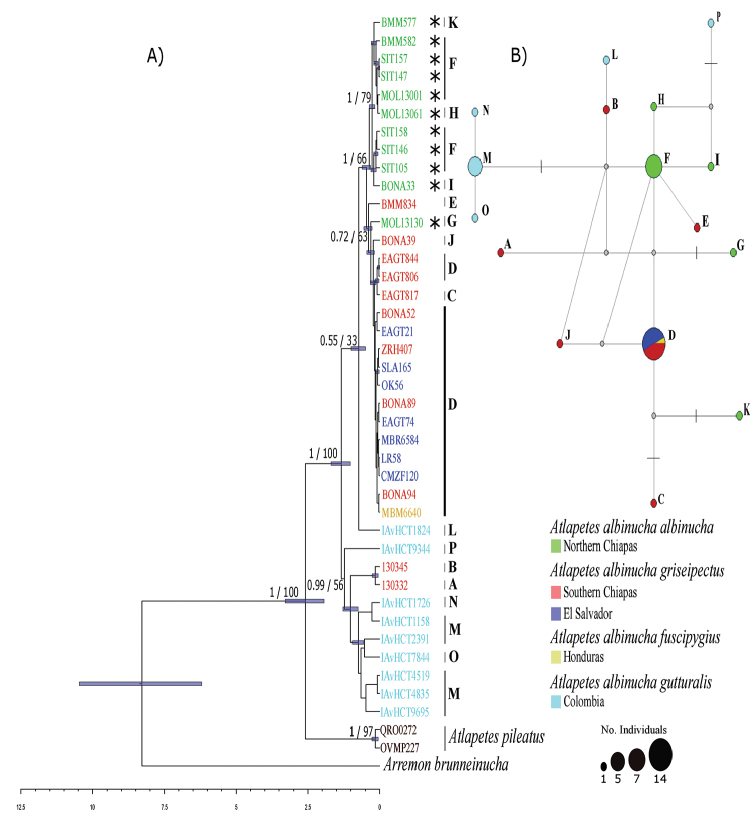
A Dated Bayesian maximum clade credibility tree showing phylogenetic relationships among members of Atlapetesalbinucha species. Node bars depict 95% HDP interval, scale bar represents millions of years. Nodal values above branches indicate posterior probabilities/ bootstrap supports of BI/ML. Capital letters depict haplotypes. An asterisk (*) indicate birds representing yellow morphs B Median-joining haplotype network for the concatenated dataset. Each color depicts the geographic provenance of samples: green-northern Chiapas (subspecies albinucha), red-southern Chiapas (subspeciesgriseipectus), blue-El Salvador (subspecies griseipectus), yellow-Honduras (subspecies fuscipygius) and light blue-Colombia (subspecies gutturalis). Each branch represents a single nucleotide change, transversal black lines along branches depict the occurrence of three mutations. Gray dots indicate median vectors inferred for the data.